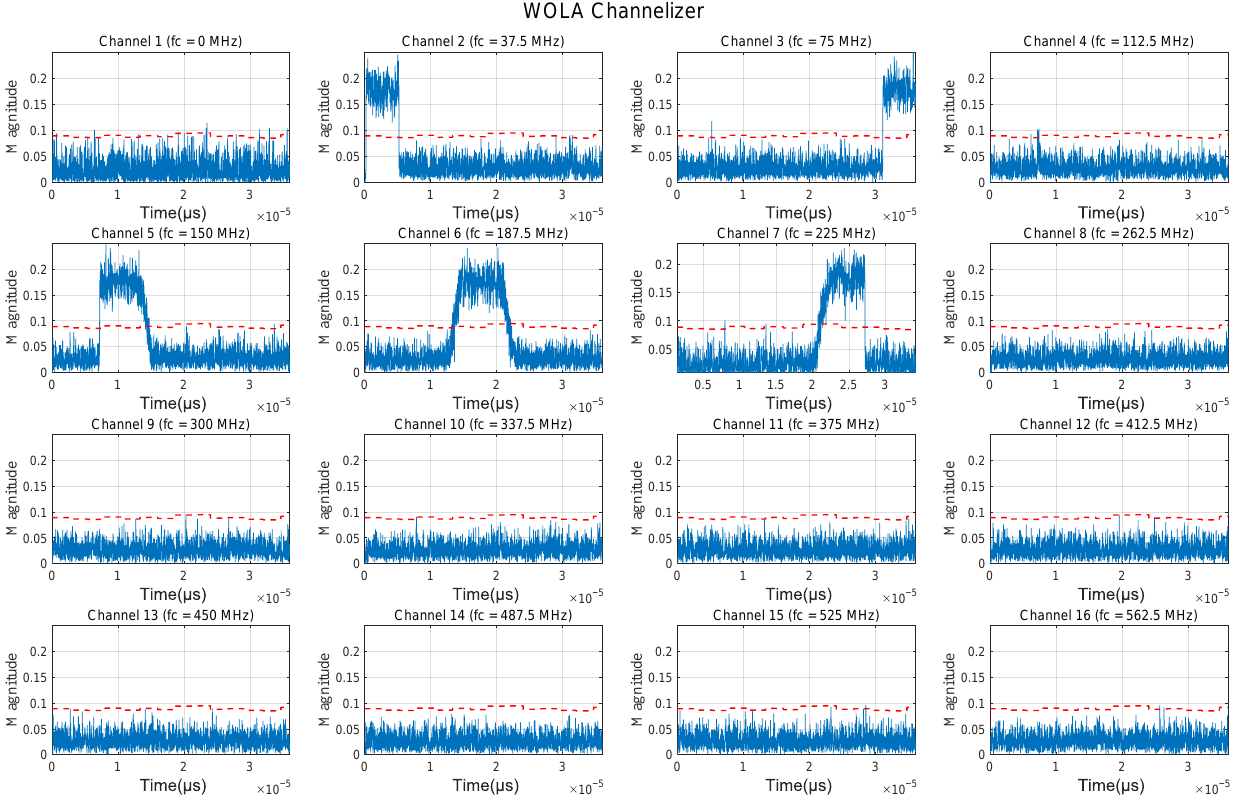
Figure 8. The WOLA channelization results. (The blue line indicates the instantaneous amplitude of the signal in the channel, and the red dashed line indicates the detection